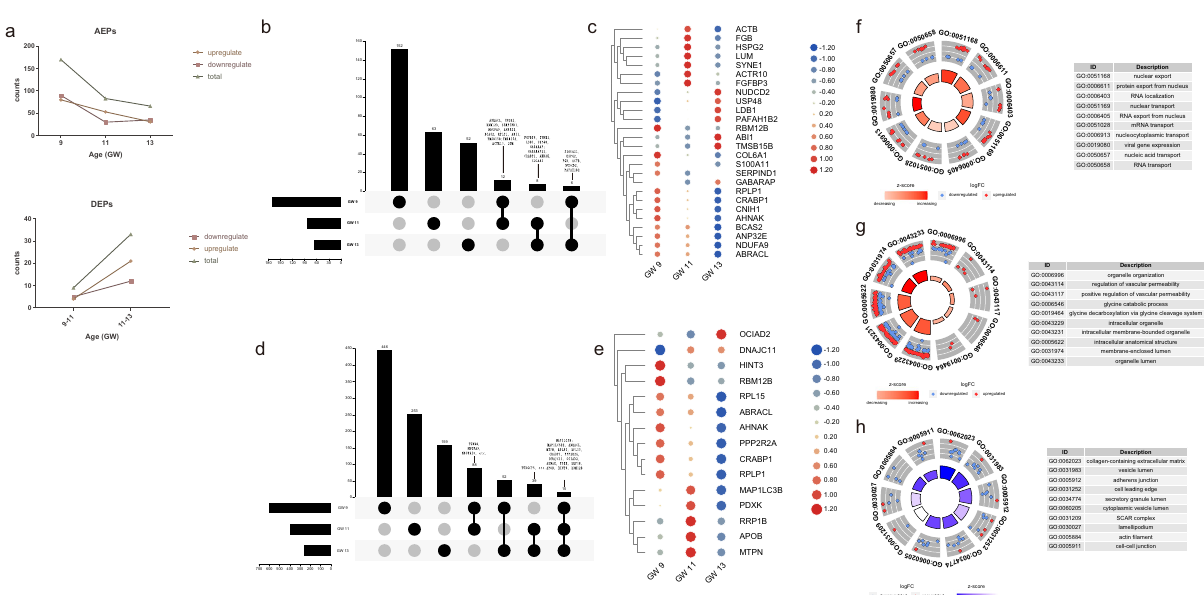
Fig. 3 AEPs between the left and right frontal lobes. a The number of DEPs increased while the number of AEPs decreased from GW 9 to GW 13. b Twenty-six (12 + 8 + 6) core AEPs with twofold changes were shared between two different GWs. c Heatmap showing differences in protein expression (fold change) in core AEPs at the three GWs. Values were scaled and clustered by row. d Fifteen proteins asymmetrically expressed with a fold change of at least 1.5 were shared between all three GWs. Some noticeable proteins are marked. e Heatmap showing differences in protein expression (fold change) in the 15 proteins asymmetrically expressed with a fold change of at least 1.5 shared among all three GWs. Values were scaled and clustered by row. f – h GO terms enriched by AEPs at GW 9 ( f ), GW 11 ( g ) and GW 13 ( h ). The blue dots represent proteins that were highly expressed on the right side of the frontal lobe, and the red dots represent proteins that were highly expressed on the left side. For a complete list of enriched GO terms, see Supplementary Data 8. AEPs asymmetrically expressed proteins, DEPs differentially expressed proteins, GW gestational week.